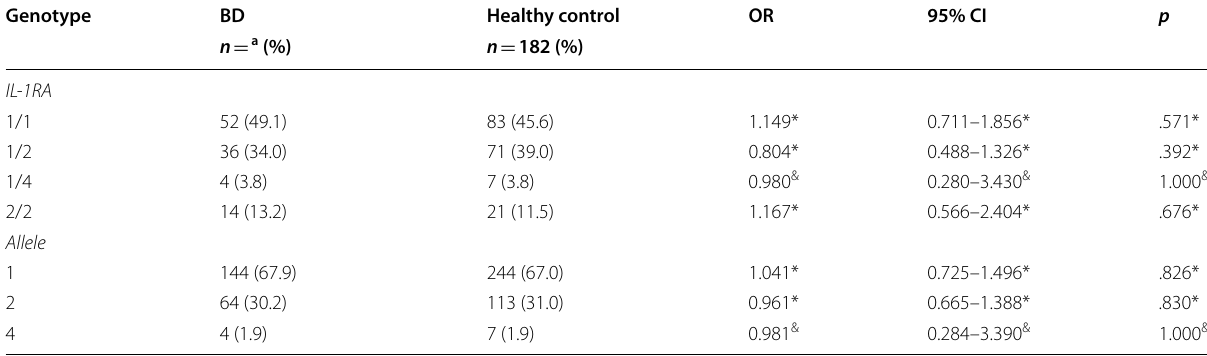
Table 3 Comparison of frequencies of IL-1RA VNTR polymorphism between BD patients and healthy controls